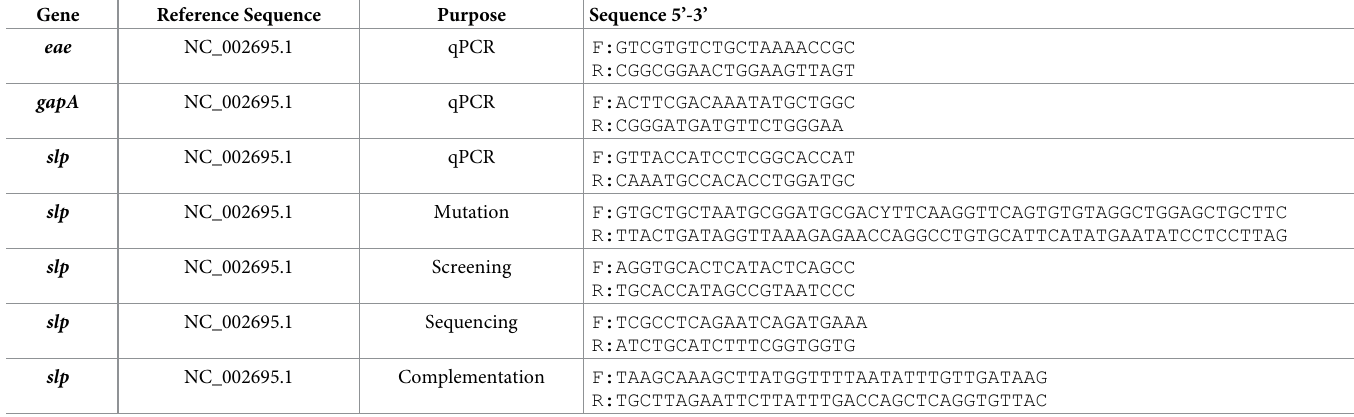
Table 2. Primer sequences used in this